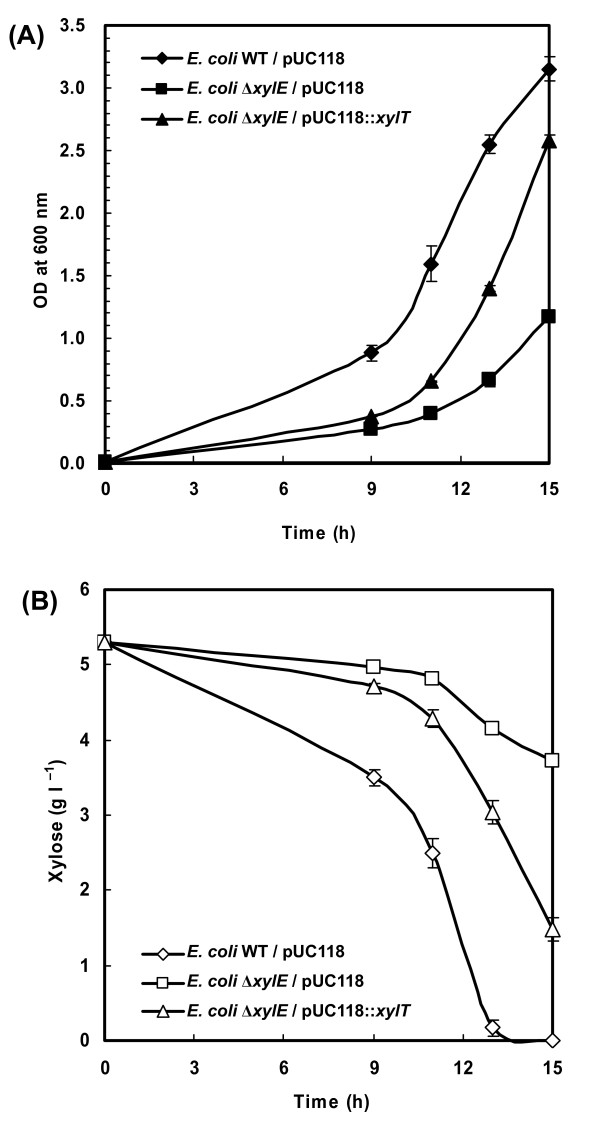
An accelerated xylose utilization of E. coli ΔxylE mutant carrying C. acetobutylicum xylT gene. Cells were grown in the minimal medium containing 5 g l-1 of D-xylose as the sole carbon source. The optical density at 600 nm (A) and xylose concentration in the medium (B) were monitored. E. coli ΔxylE mutant strain with an empty vector was used a control. Data shown are means ± standard deviations calculated from triplicate individual experiments.